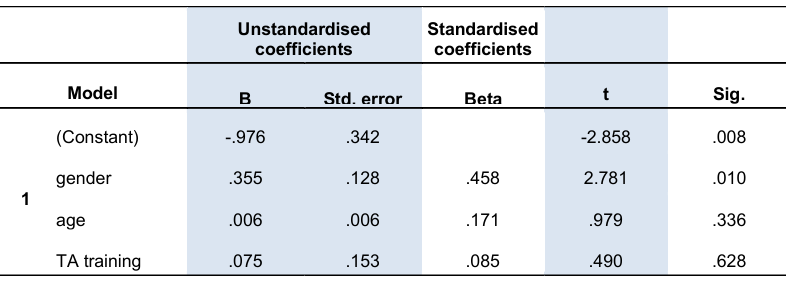
Table 5b: Coefficients a